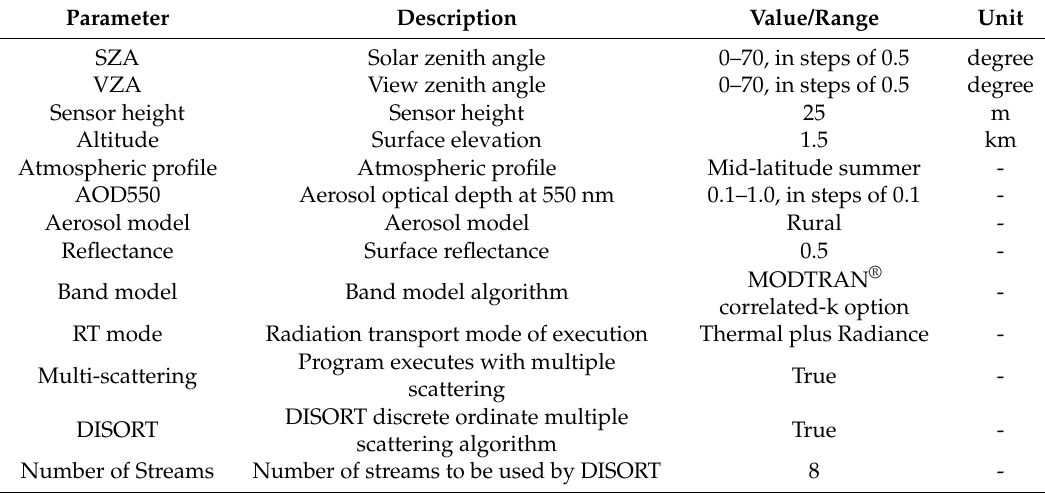
Table 1. Main input parameters for MODTRAN 5